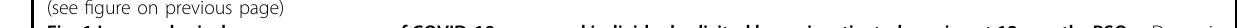
(Supplementary Fig. S2d – g). Both IgM and IgA levels in 7 of 9 individuals reached peak at 1 month PSO and fell below the positive threshold thereafter. By contrast, IgG and NAbs decreased slowly and remains 100% (9/9) and 78% (7/9) positive at 12 months PSO.